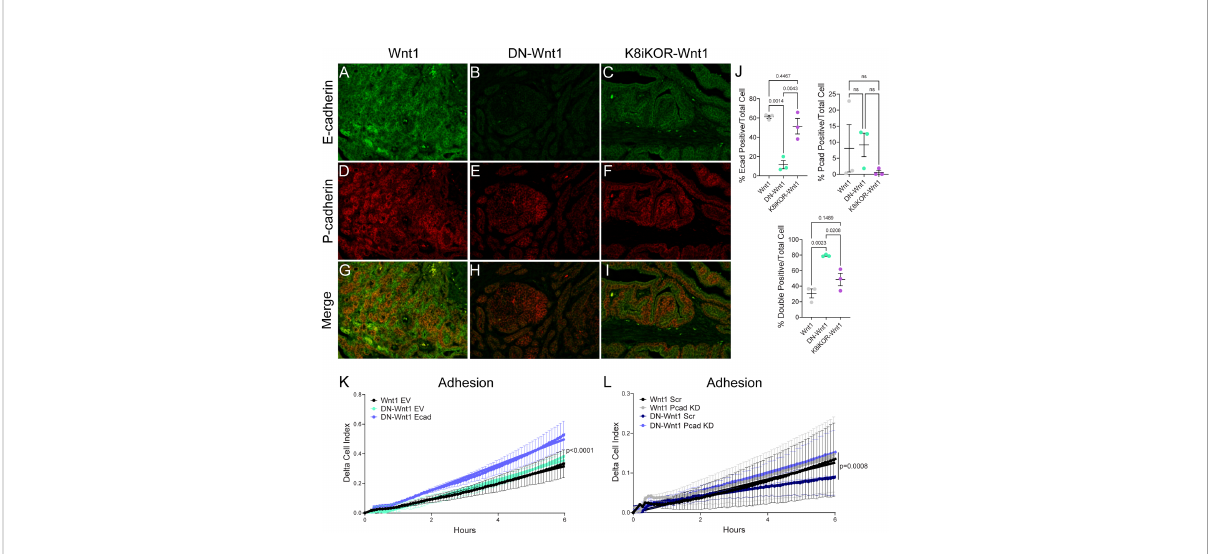
FIGURE 8 Altered cadherin expression in tumors with reduced IGF1R. (A – I) Representative images of E-cadherin (green) or P-cadherin (red) immunostaining in Wnt1 (A, D, G) , DN-Wnt1 (B, E, H) , and K8iKOR-Wnt1 (C, F, I) primary tumors. (J) E-cadherin, P-cadherin, and double positive cell count graphs of primary tumors. Statistic: One-Way ANOVA with Tukey ’ s Multiple Comparison post-hoc test. K. Adhesion (delta cell index) over time in Wnt1 or DN-Wnt1 primary tumors with empty vector (EV) or E-cadherin overexpression (Ecad). n = 3; Statistic: Non-linear regression. (L) Adhesion (delta cell index) over time in Wnt1 or DN-Wnt1 with P-cadherin knockdown (Pcad KD). n = 3; Statistic: Non-linear